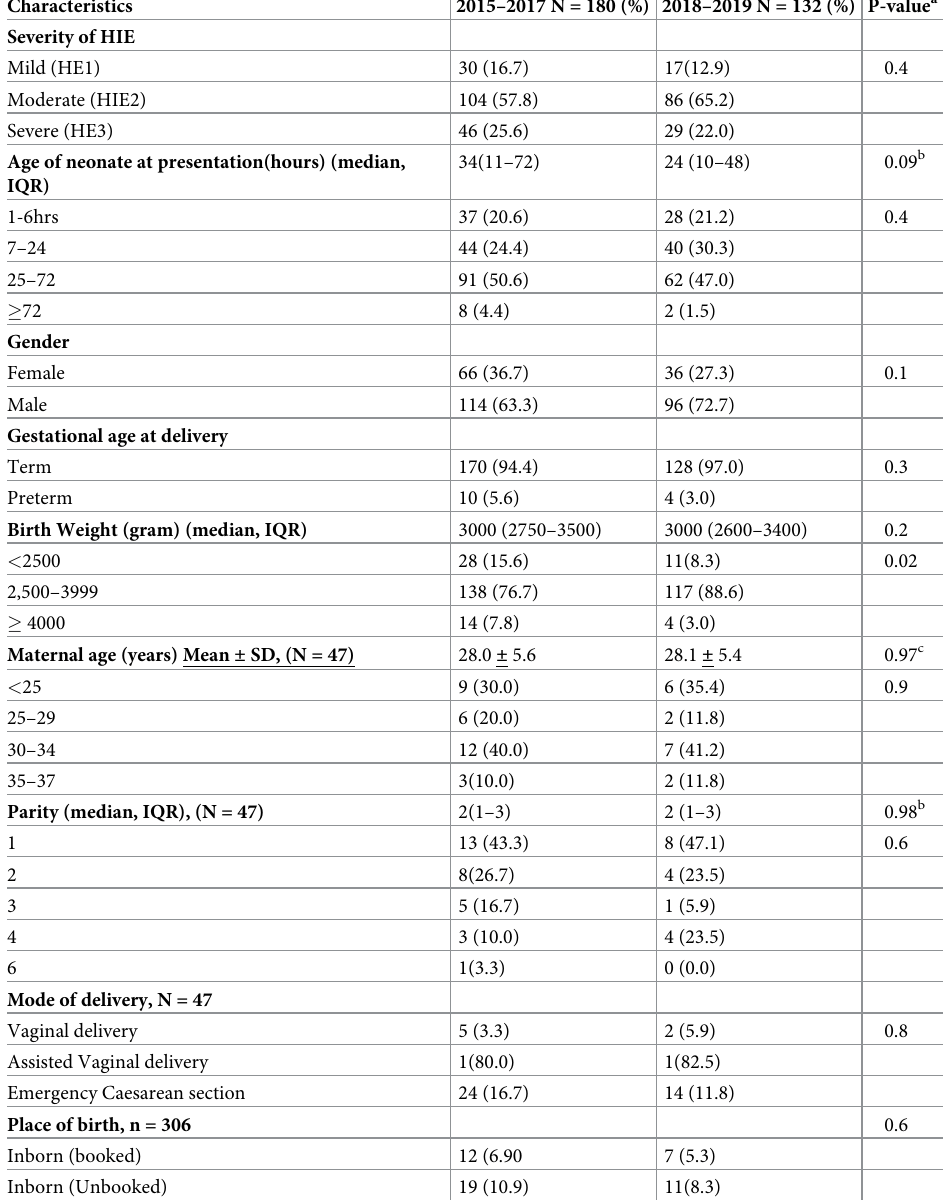
Table 3. Maternal and neonatal characteristics by time period.